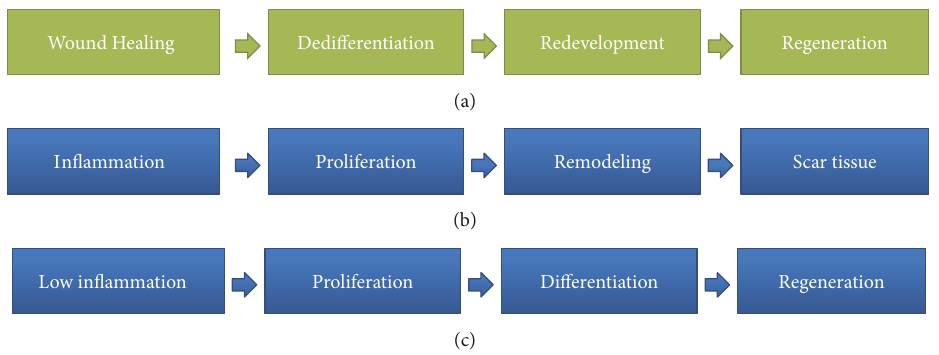
Figure 2: Amphibian regeneration versus (a) attempted regeneration in mammals (b and